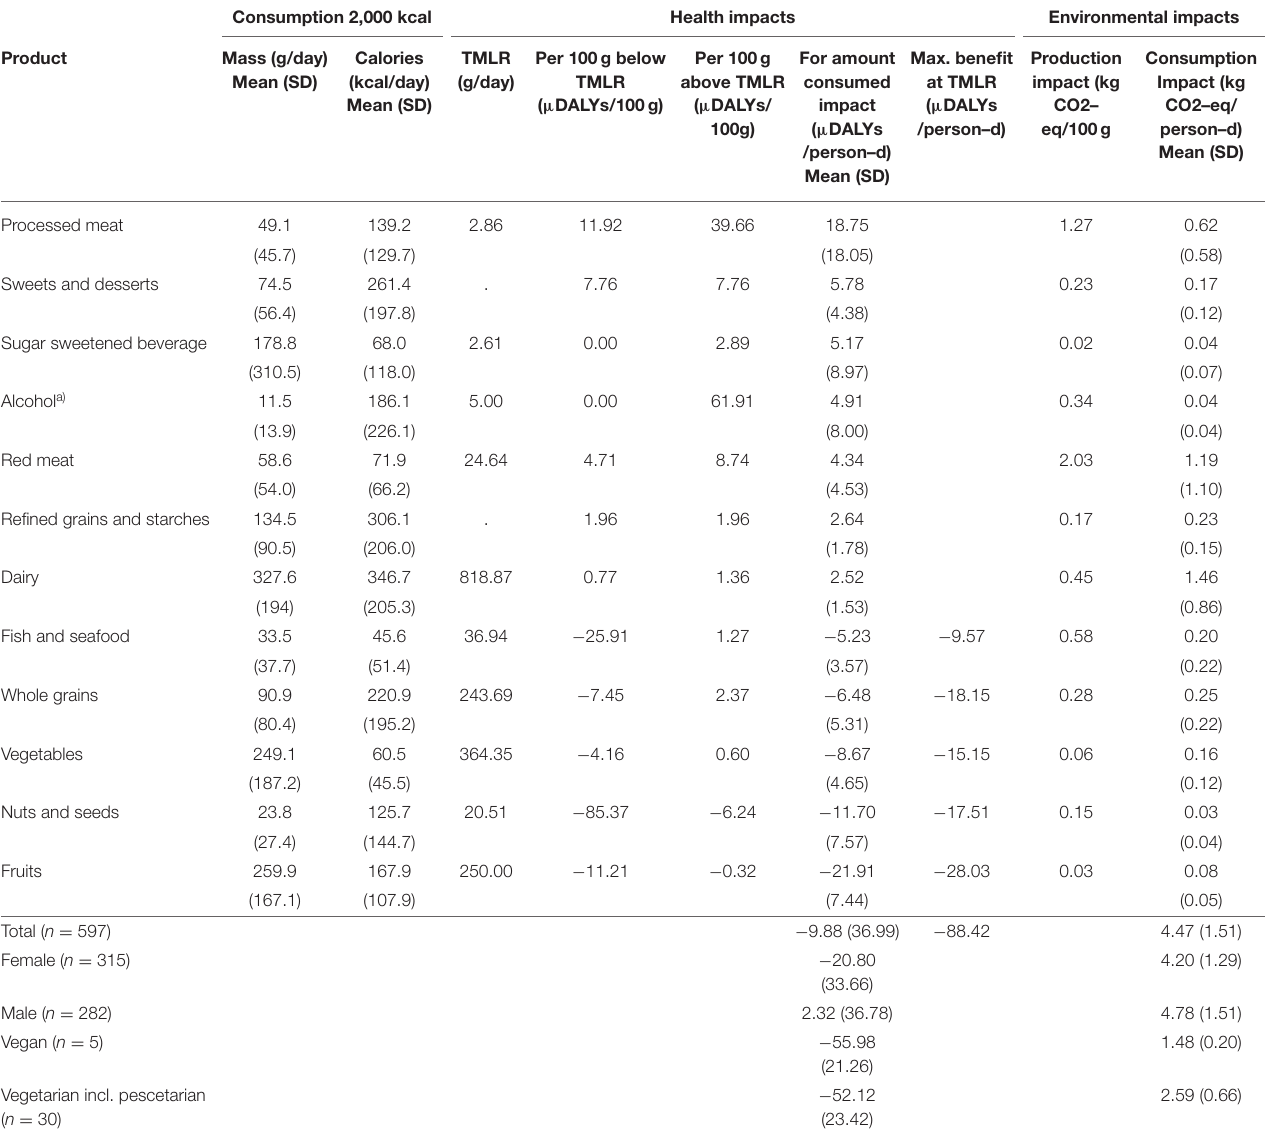
TABLE 1 | Self-reported intake of twelve foods normalized for a 2,000 kcal diet and corresponding nutritional health and environmental impacts. Foods listed from most detrimental to most